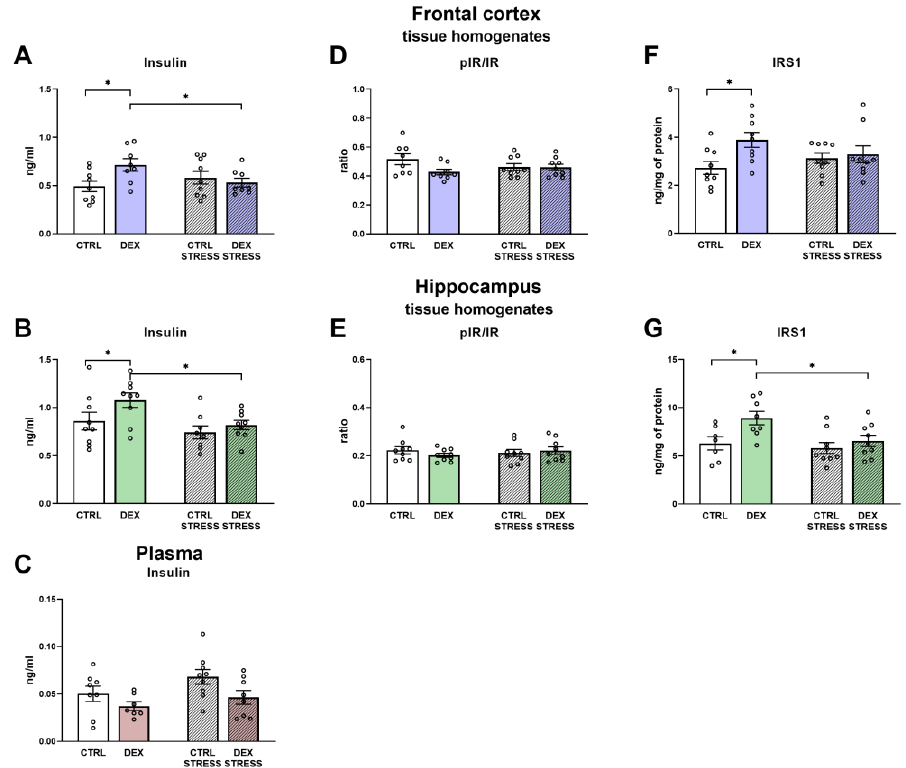
Figure 10. The effects of DEX treatment and acute stress on the levels of insulin, phospho-insulin receptor (pIR/IR), IRS1 in the tissue homogenates of the frontal cortex ( A , C , E ) and the hippocampus ( B , D , F ) and insulin in the plasma ( G ); proteins levels were determined with ELISA assays; * p < 0.05, n = 7–9 The results are expressed as the mean ± SEM. Statistics: two-way ANOVA, followed by the Duncan test.